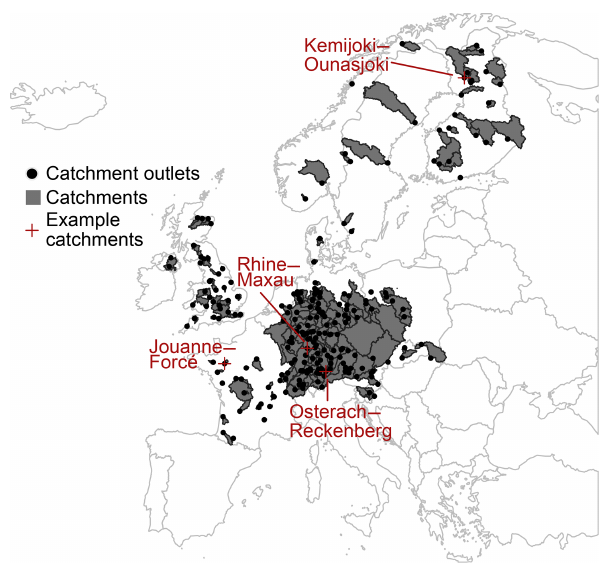
Figure 2. The 234 catchments in Central Europe selected for the analysis based on model performance and the availability of catch- ment boundaries and characteristics. The four example catchments, used for illustration purposes, are highlighted in red. (a) Kemijoki– Ounasjoki (strong summer flood regime). (b) Osterach–Reckenberg (summer flood regime). (c) Rhine–Maxau (winter flood regime). (d) Jouanne–Forcé (strong winter flood